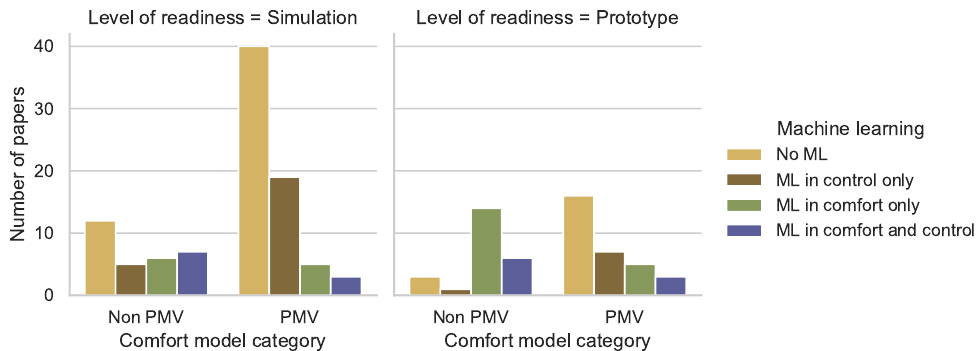
Figure 17. Use of ML by comfort model category and level of readiness.